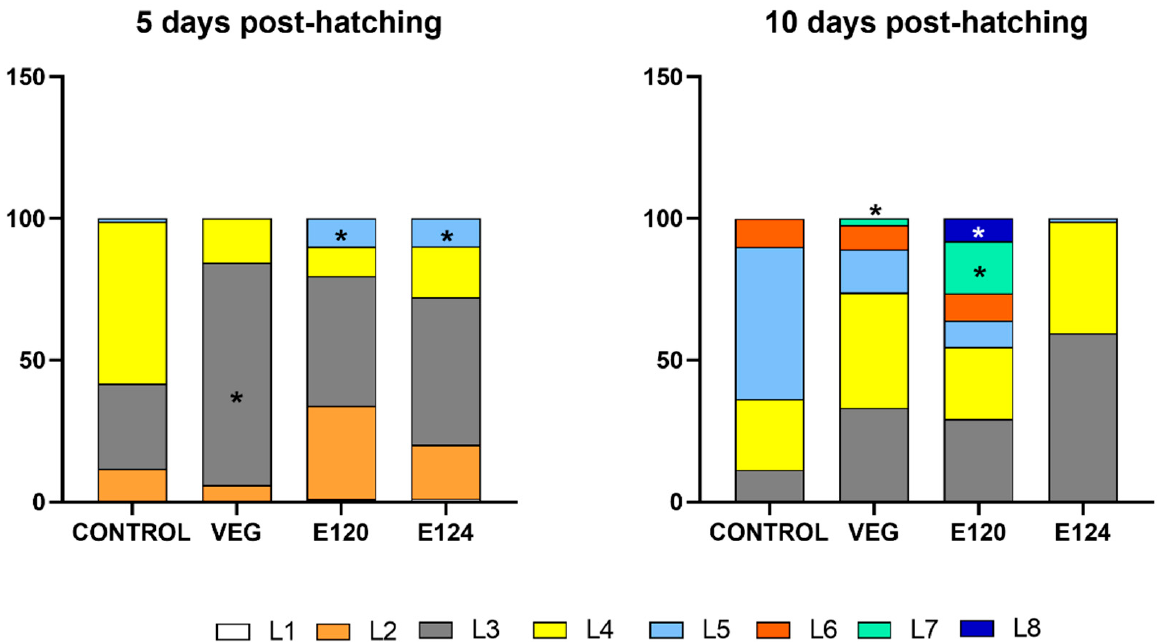
Figure 4. Naupliar stages (%) in Artemia salina samples exposed to vegan red VEG, E120, or E124.